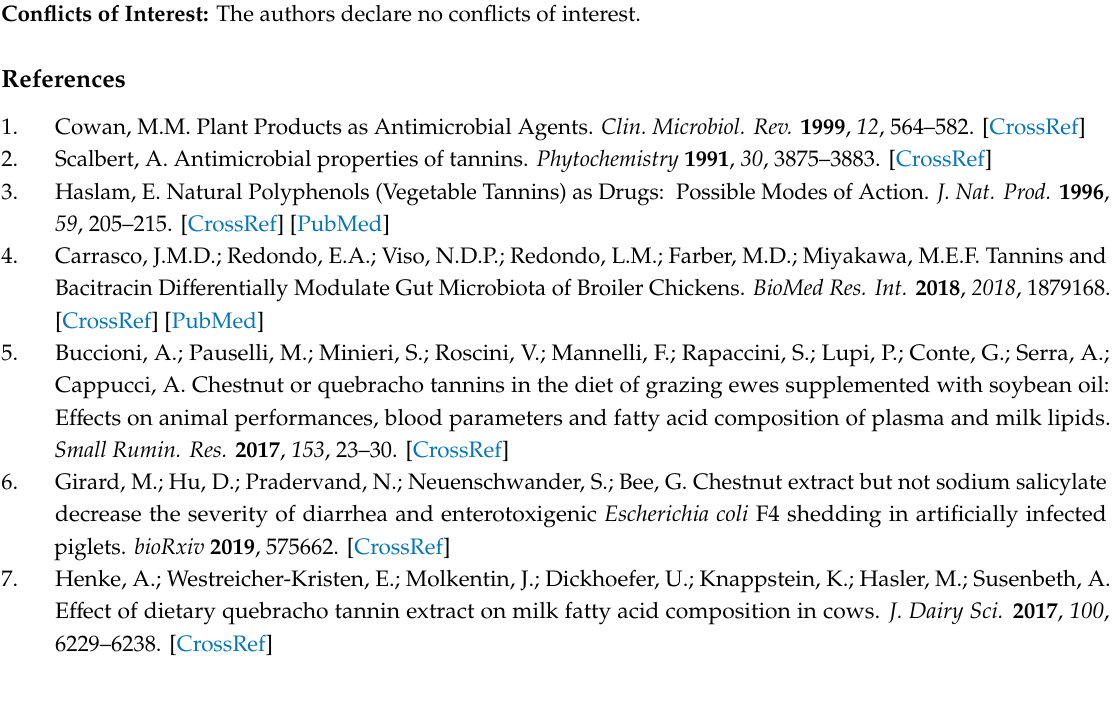
Table S1: PCR primer’s conditions, Figure S1: PCR gel electrophoresis, Figure S2: E ff ects of (0–1200 µ g / mL) of Ch and Qu tannin extracts on E. coli F4 + and F18 + growth over time